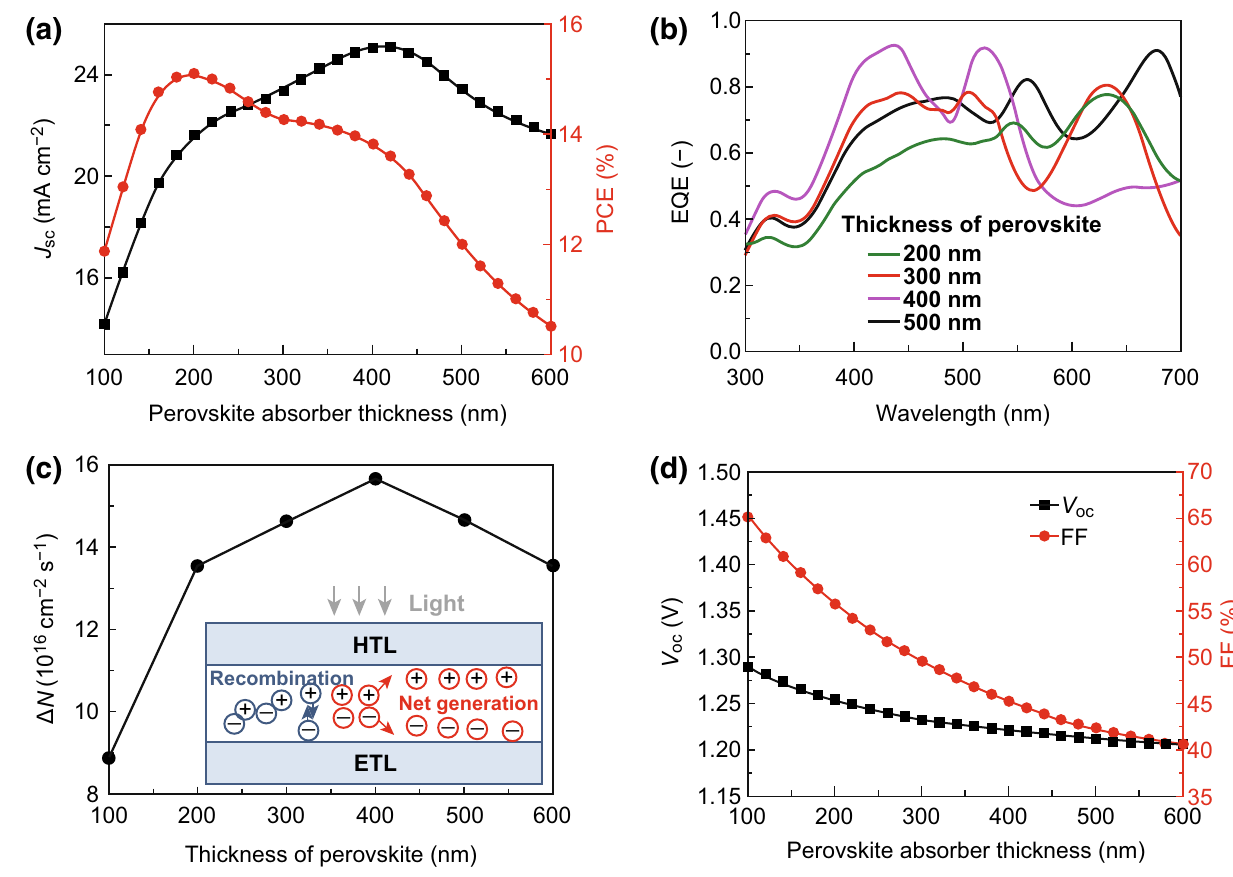
Fig. 2 a , d Device parameters as functions of the perovskite thickness for a CsPbI 3 -based PSC with a single-layer ZnO ETL. b EQE spectra and c net carrier generation rate for CsPbI 3 -based PSCs with a single-layer ZnO ETL under different perovskite thickness conditions